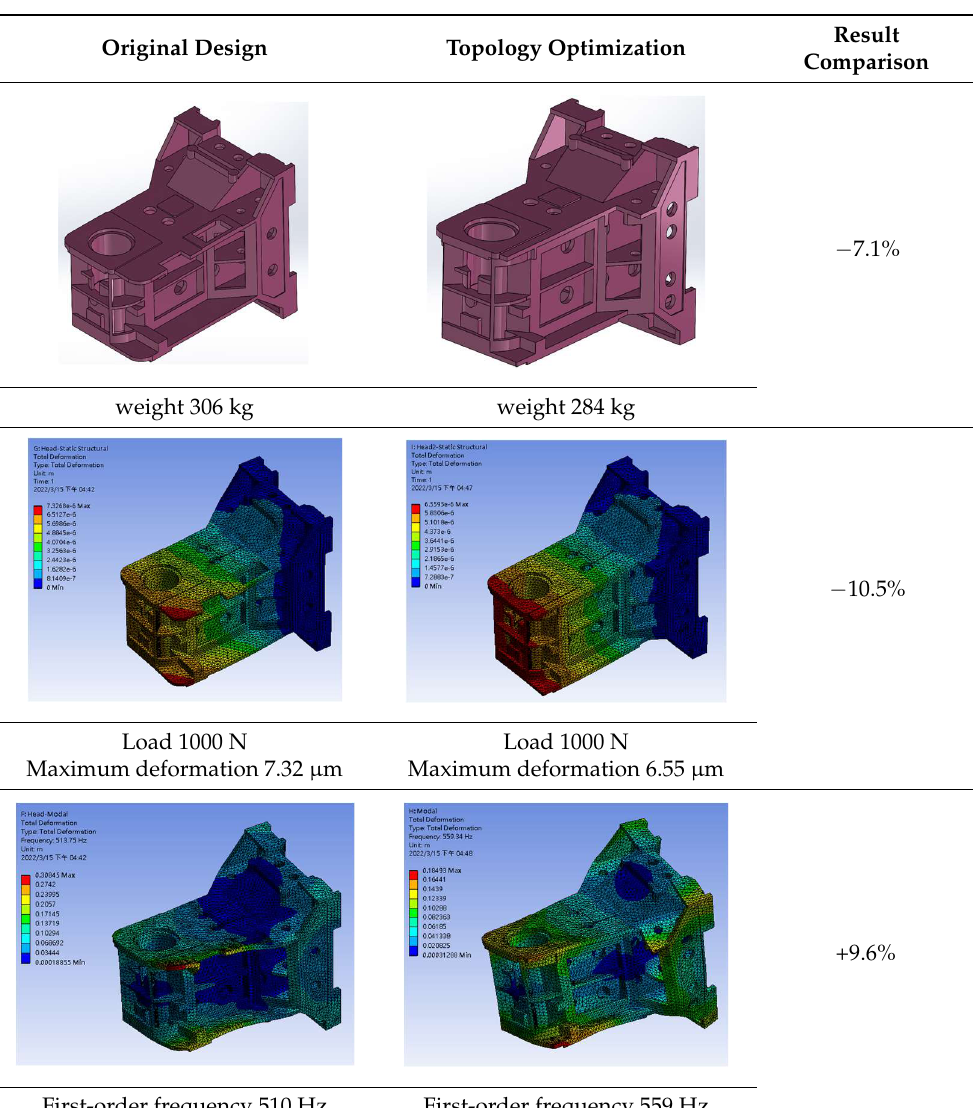
Table 11. Head-optimization results comparison.